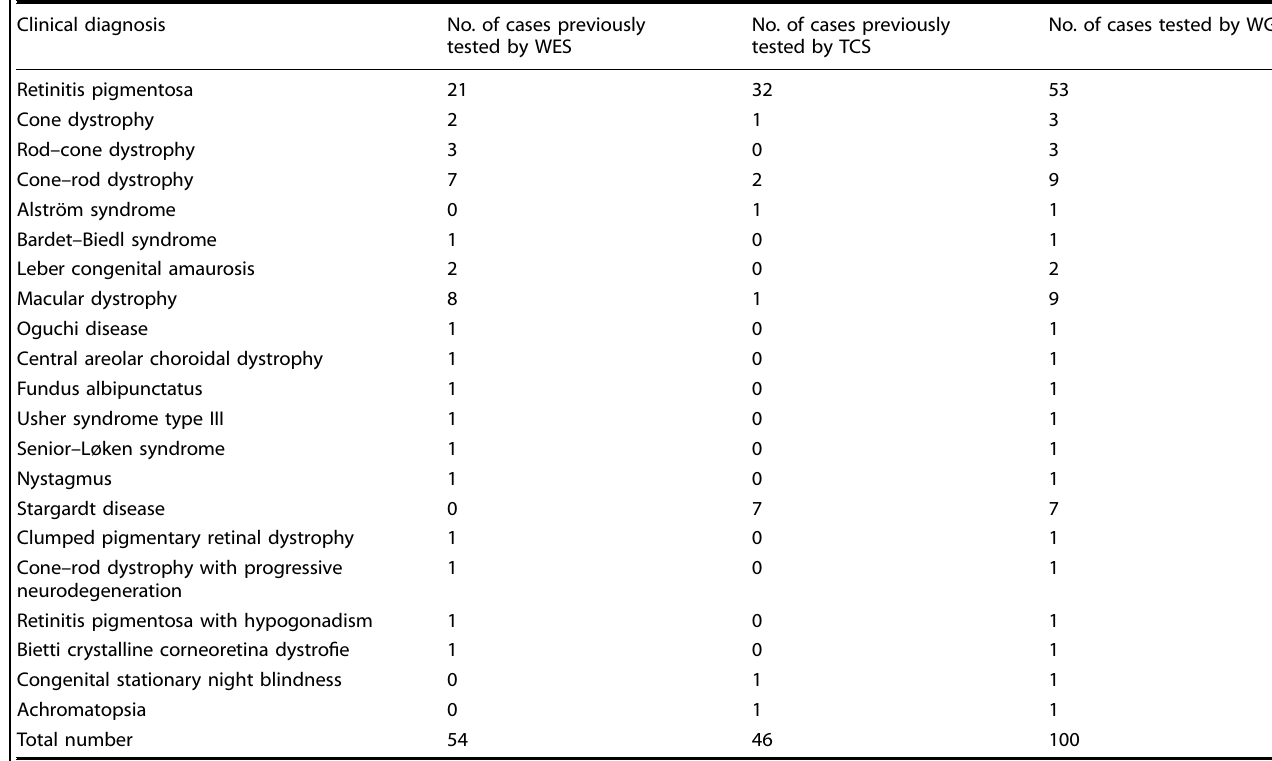
Table 1. Phenotypic diversity of patients and the number of cases referred for TCS, WES, and WGS. Clinical